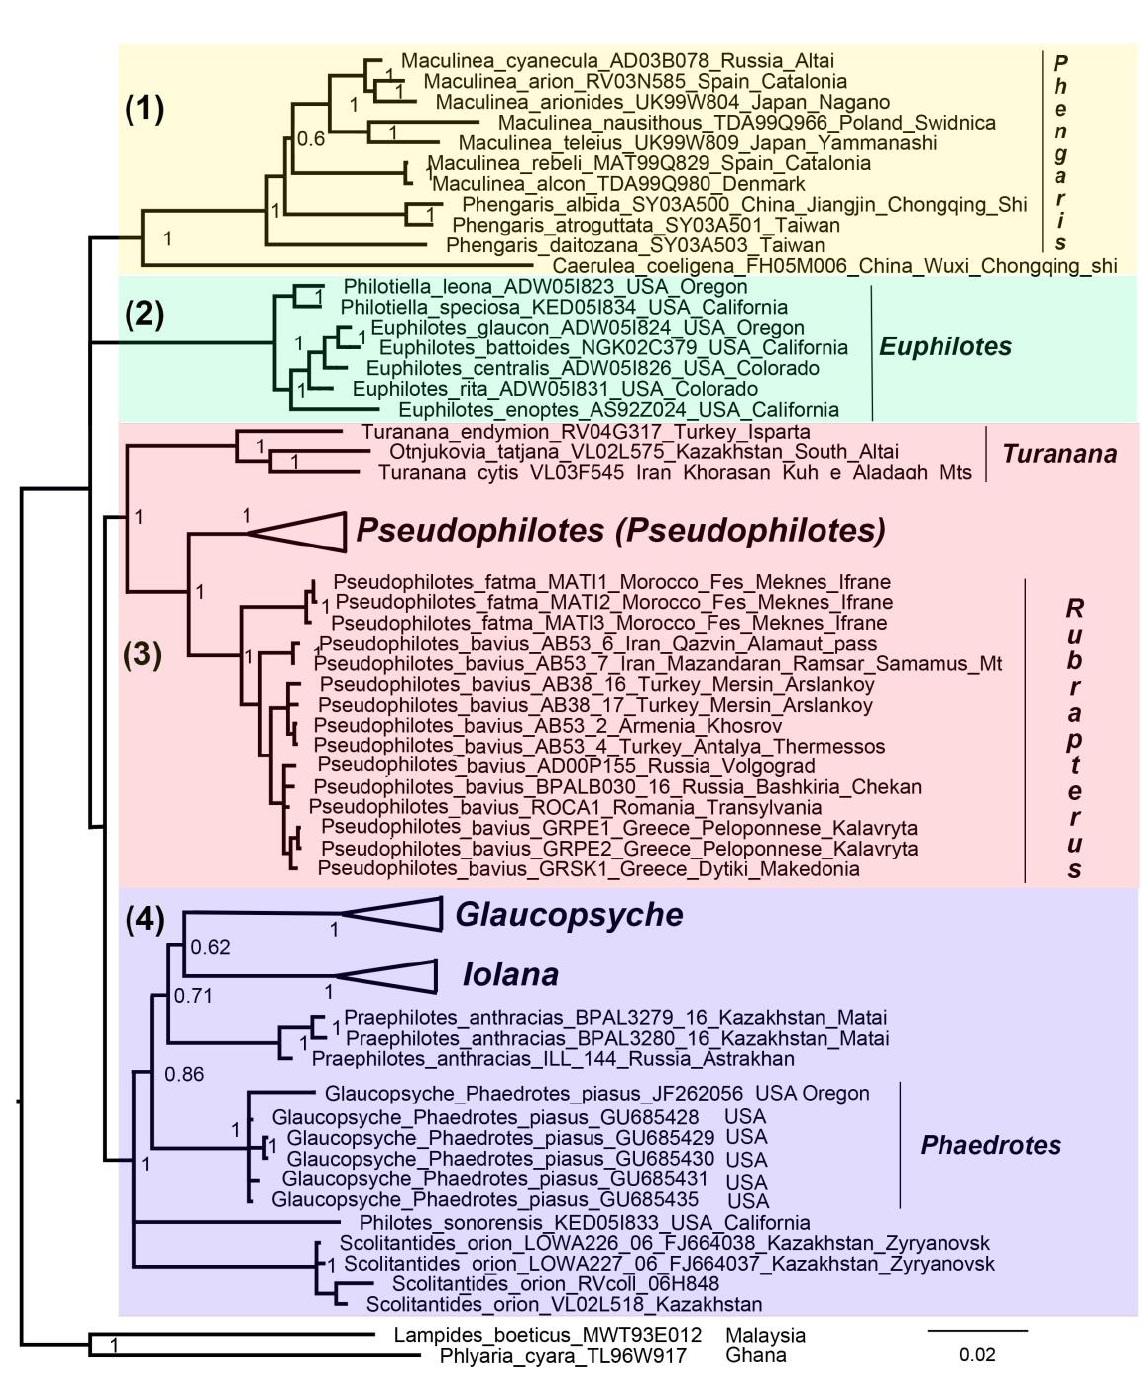
Figure 3. BI of the subtribe Scolitantidina based on concatenation of nuclear and mitochondrial genes ( 28S + H3 + EF1-a + wingless + ITS2 + COI + COII dataset). Posterior probabilities are indicated at the nodes. (1), (2), (3), and (4) are the four supported main lineages within the subtribe Scolitantidina.